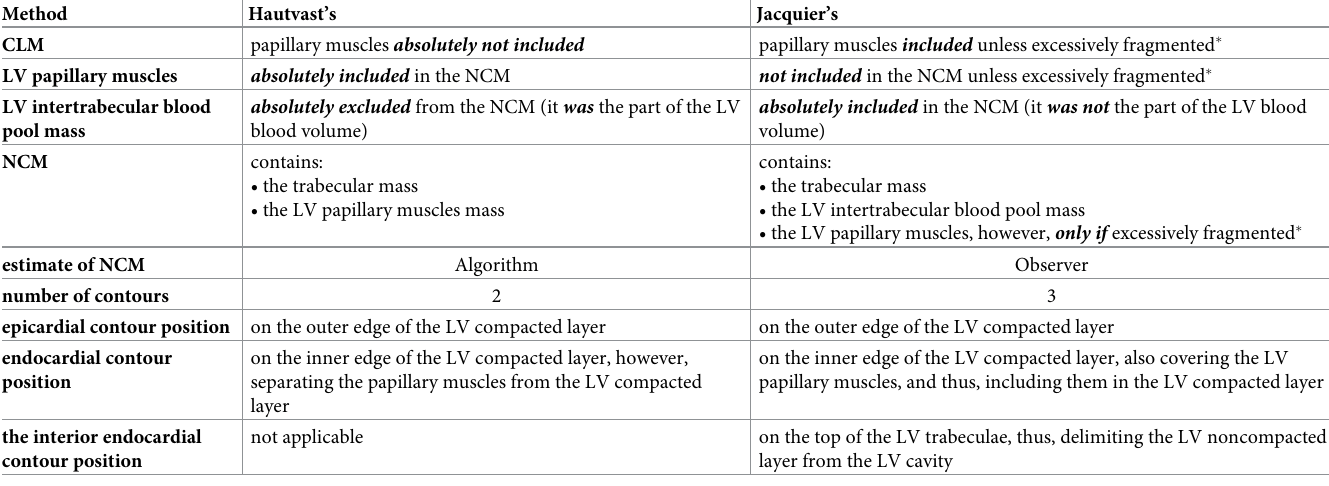
Table 3. The detailed comparison between the two methods of the trabecular mass measurement: By Jacquier et al. and by the semi-automatic Hautvast’s algorithm implemented into Philip’s CMR software [10,12].